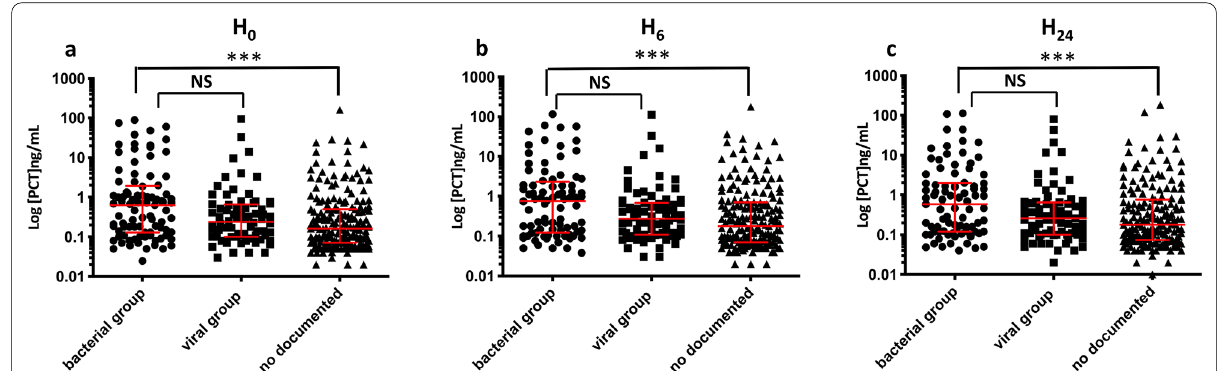
Fig. 1 PCT levels at inclusion (PCT‑H 0 ) (panel a), at 6 hours (PCT‑H 6 ) (panel b) and day 1 (PCT‑H 24 ) (panel c) after inclusion, in accordance with the documented infection group *** p <